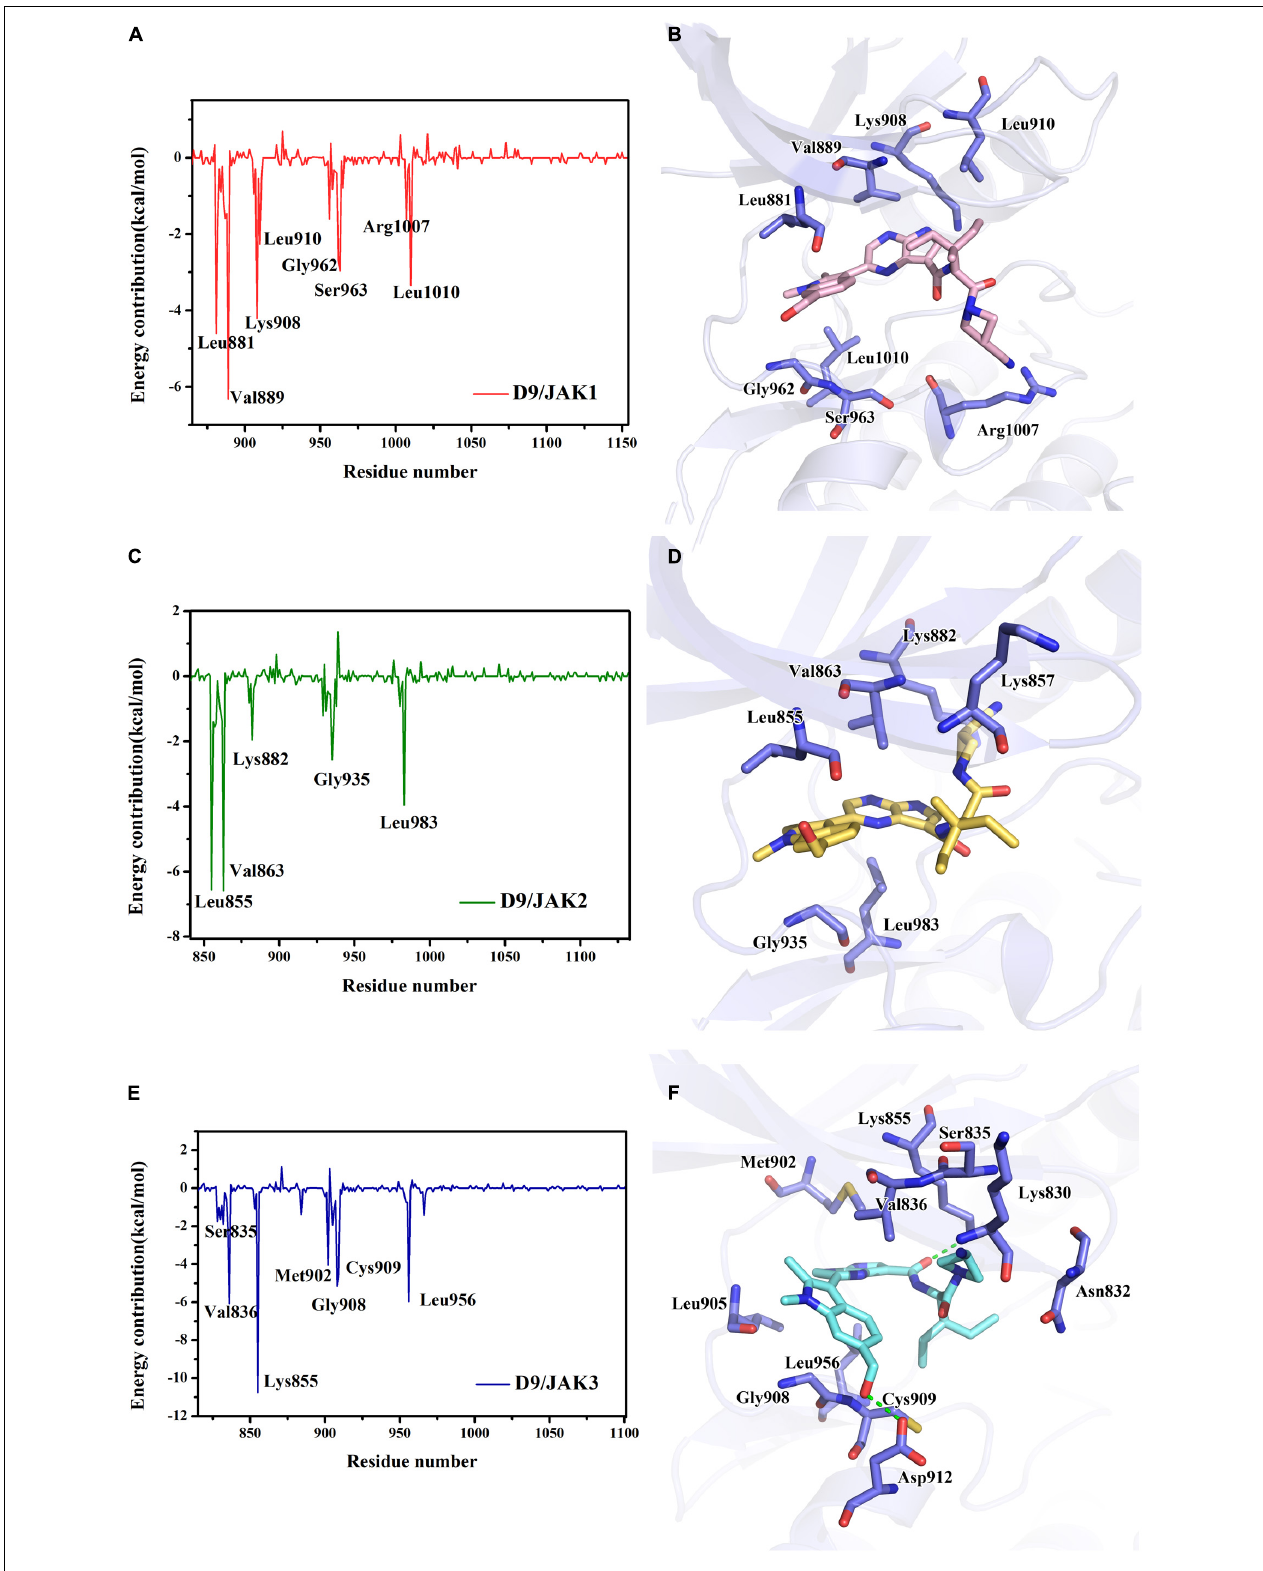
FIGURE 5 | The plots of binding-free energy decomposition on per-residue for (A) D9/JAK1, (C) D9/JAK2, (E) D9/JAK3. The binding patterns of D9 in the active domain of (B) JAK1, (D) JAK2 and (F) JAK3.